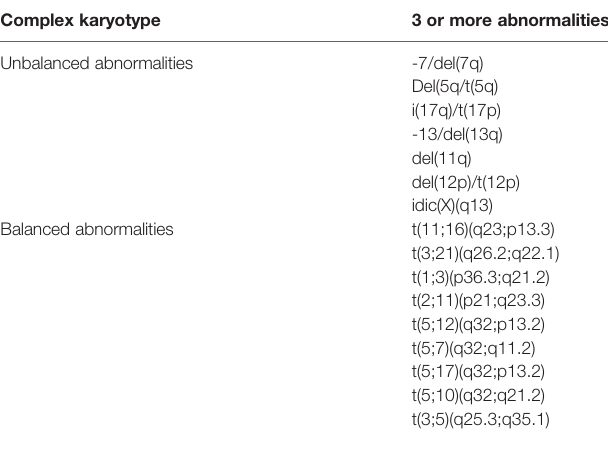
TABLE 3 | Cytogenetic abnormalities for the diagnosis of AML with myelodysplasia-related changes. Complex karyotype 3 or more abnormalities Unbalanced